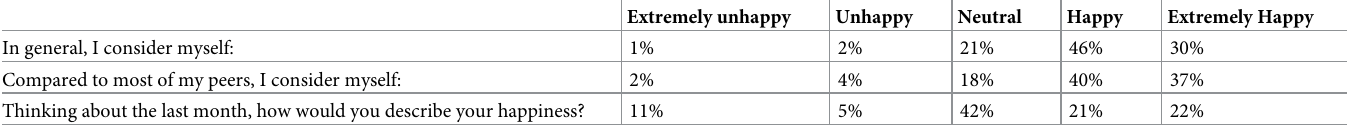
Table 5. Happiness responses, by